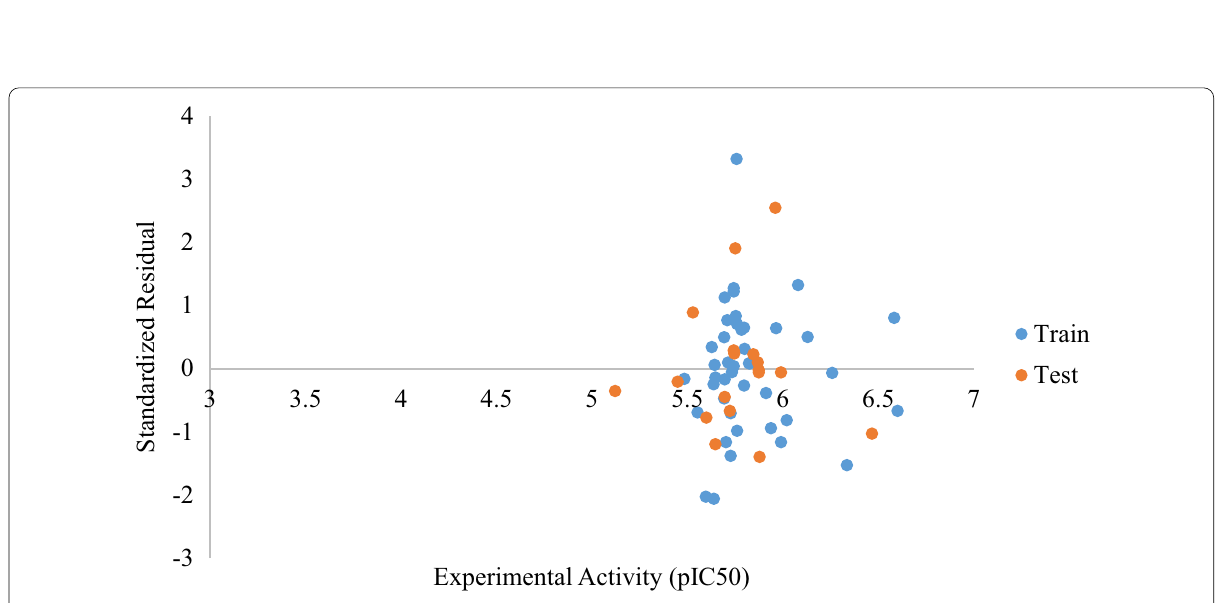
Fig. 2 Graph of predicted activities versus inhibition concentration (anti-proliferative activities)